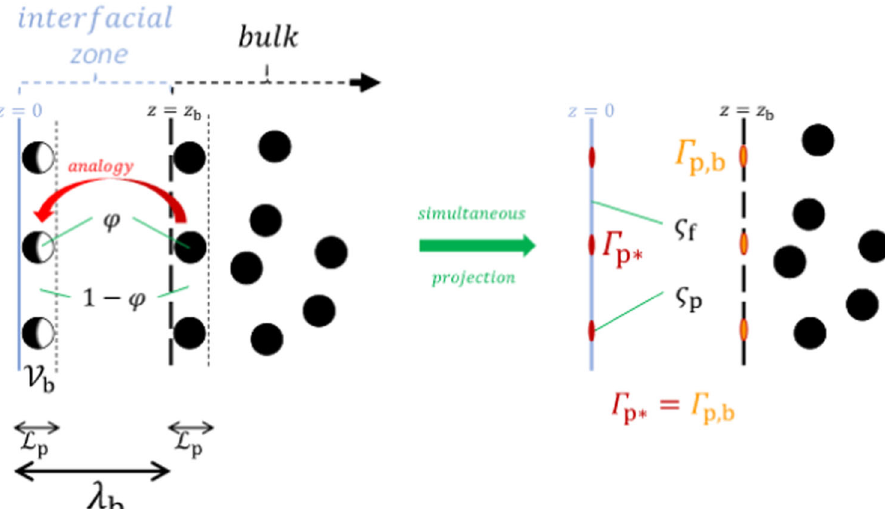
Fig. 2 Projection of bulk concentration. Analogy of an imaginary projection of the nanoparticles at an imaginary surface at z = z b with respect to the real projection on the dividing surface at z = 0. The two resulting molar concentrations per unit surface should be equal in the de fi nition of the surface excess